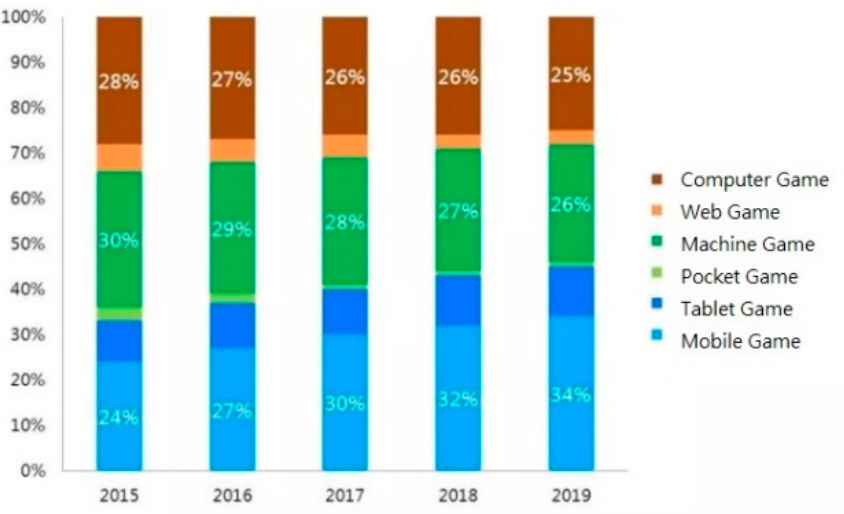
Figure 1. Market share in different kind of games. Data source: Newzoo company.